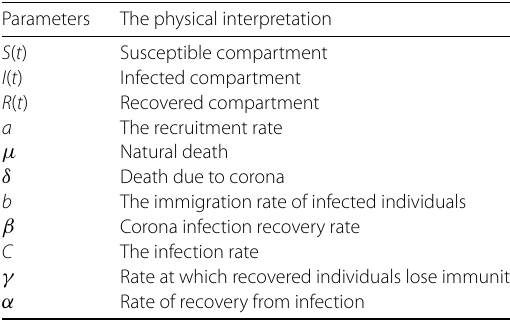
Table 1 The physical interpretation of the